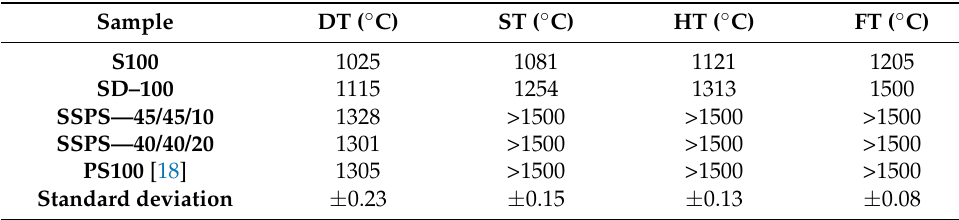
Table 2. Melting temperatures of the pellet samples.